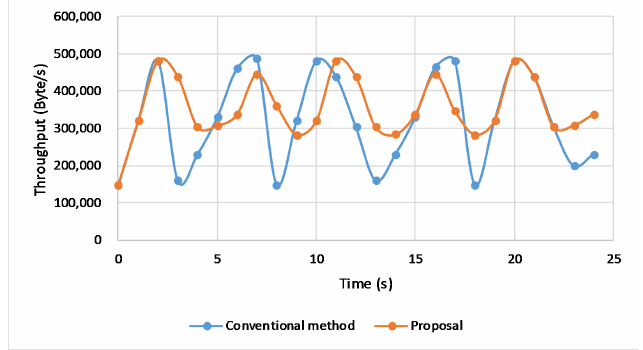
Figure 6. Real-time